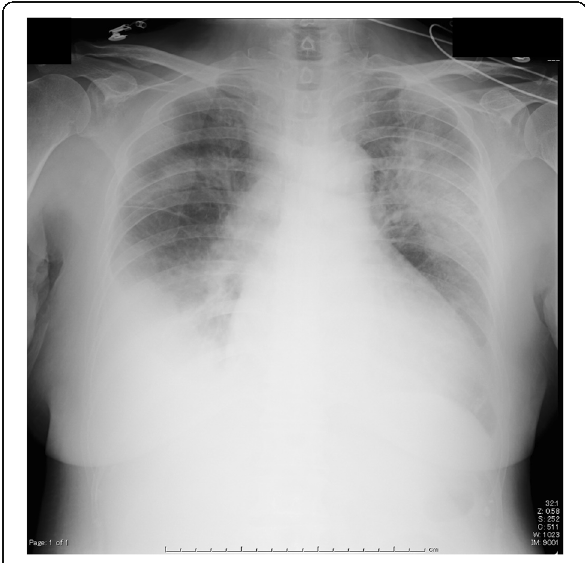
Fig. 1 Chest radiograph indicated bilateral pleural effusion and pulmonary